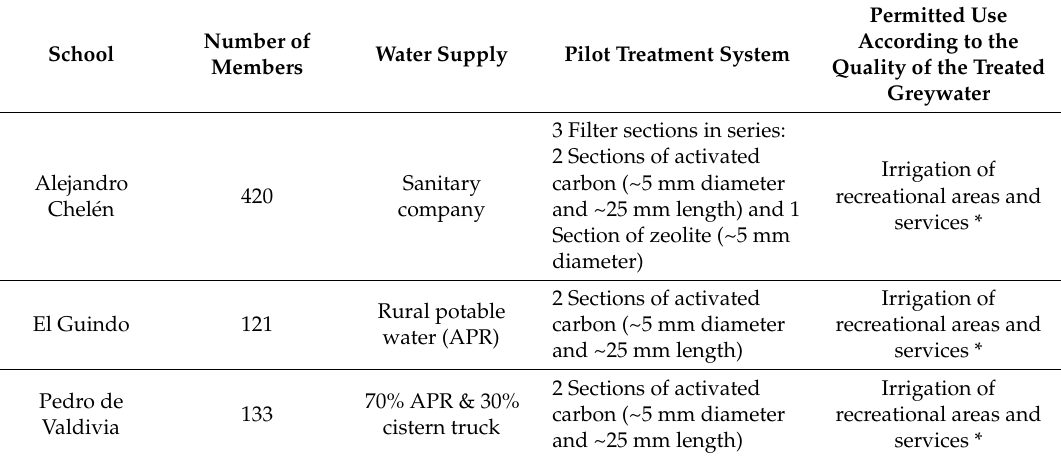
Table 1. Characteristics of the case studies.